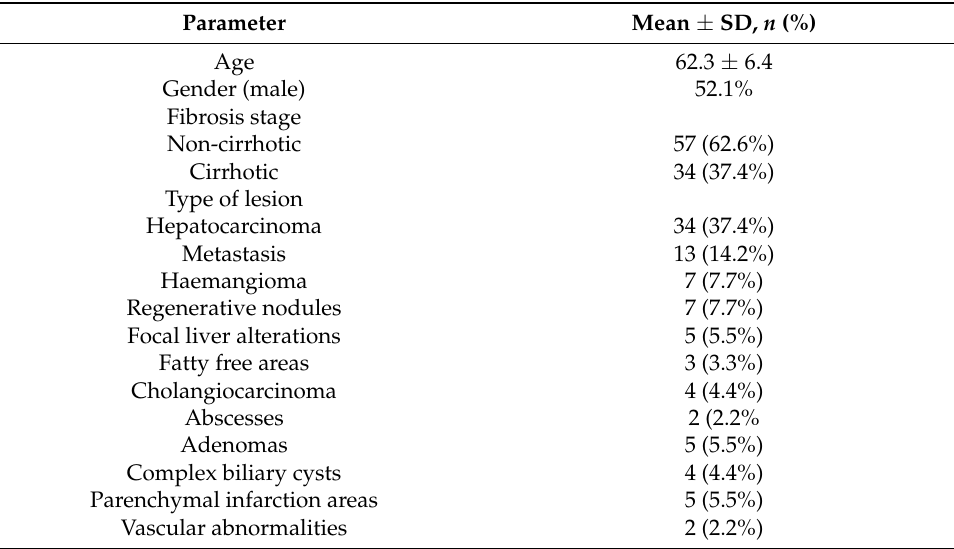
Table 2. Patients baseline characteristics.